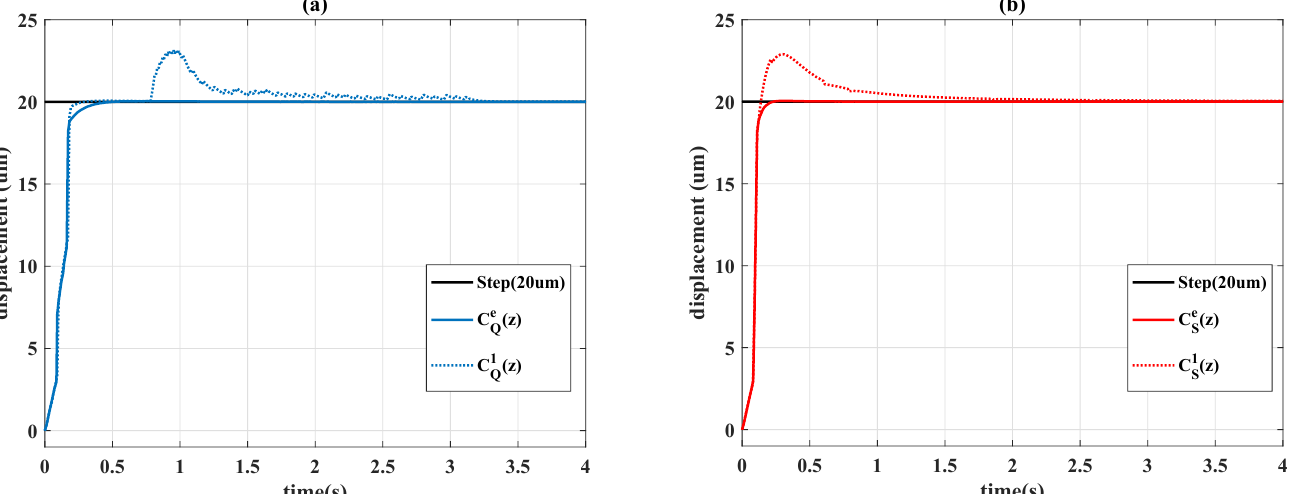
Figure 9. Step responses: ( a ) Q-learning; ( b ) Sarsa.